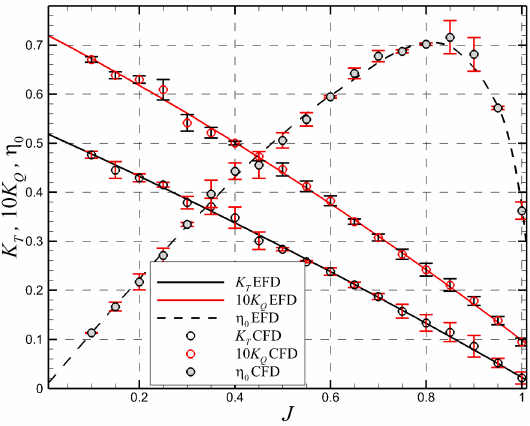
Figure 3. POW diagrams.